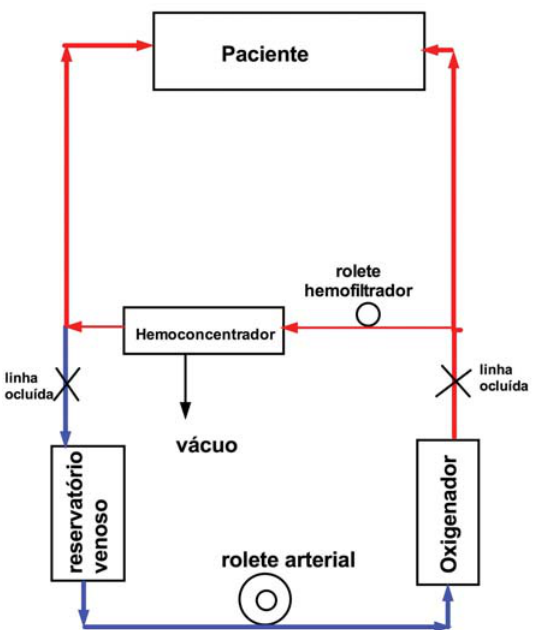
Fig. 1 - Esquema de ultrafiltração modificada. Observar que